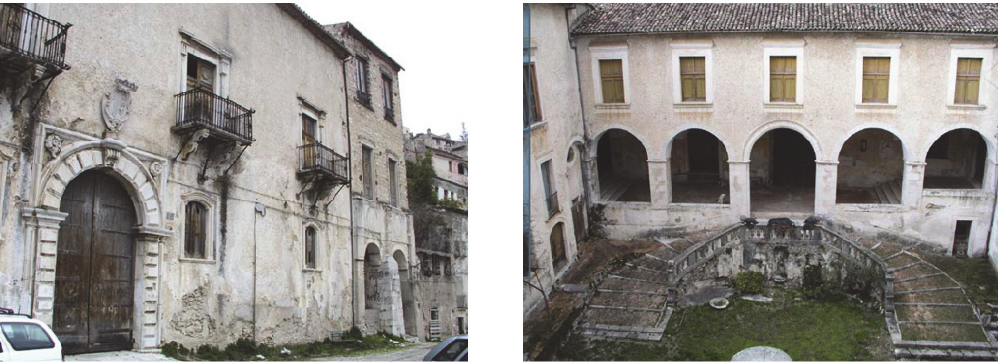
Figure 5: External front views.